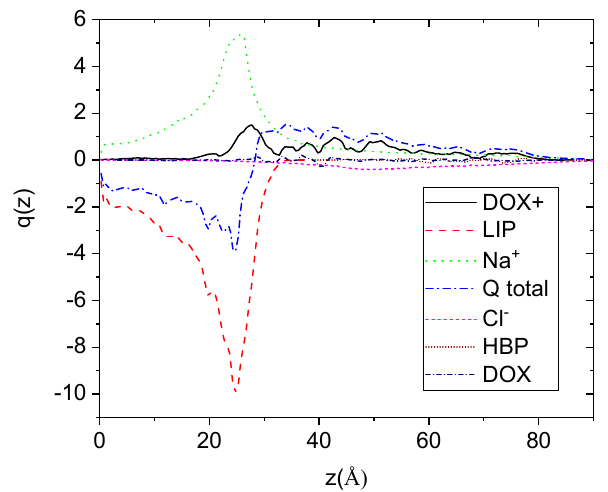
Figure 7. Symmetrized charge distributions of all the moieties in the examined system, as a function of the distance from the plane, which is defined from the center of mass of the lipid membrane (considered as an individual molecule) and the two principal inertia axes, which are parallel to the lipid layer. “Q total” denotes the sum of all the component charge profiles.